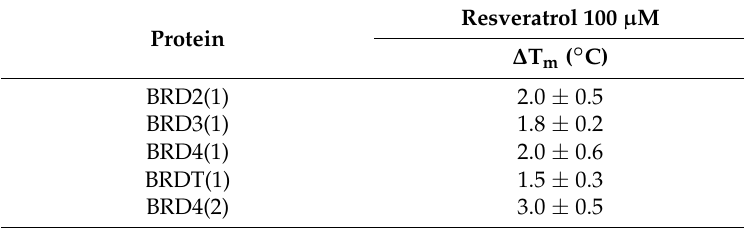
Table 1. Thermal stability data for bromodomains in the presence of resveratrol